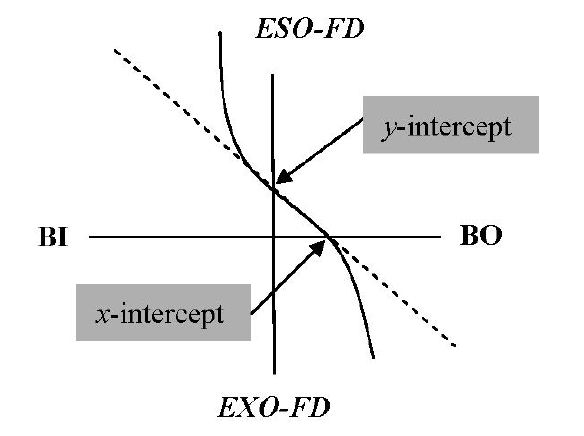
Figure 1 . An example of a typical Type I Ogle curve of forced vergence disparity is indicated. The x -axis or axis of forced or induced vergence demand , has units of prism dioptres and can range from say 20 pd BI to 30 pd BO, depending on stimulus distance, measurement method and other issues. The y -axis, or axis of FD , has units of minutes of arc and positive values indicate eso-FD. The intersect of the two axes or origin would represent 0 pd FD with no prism before the two eyes. As BO prism is increased in magnitude, so greater convergence is induced; while increasing BI values indicates greater forced divergence. The curve (of forced vergence disparity) indicates the unique fixation disparities that this hypothetical subject displayed through the corresponding induced vergence posture. The y -intercept indicates the FD that this individual had through 0 pd while the x -intercept is the associated phoria, that is, the amount of prism (here a BO value of some sort) that was needed to reduce the FD to